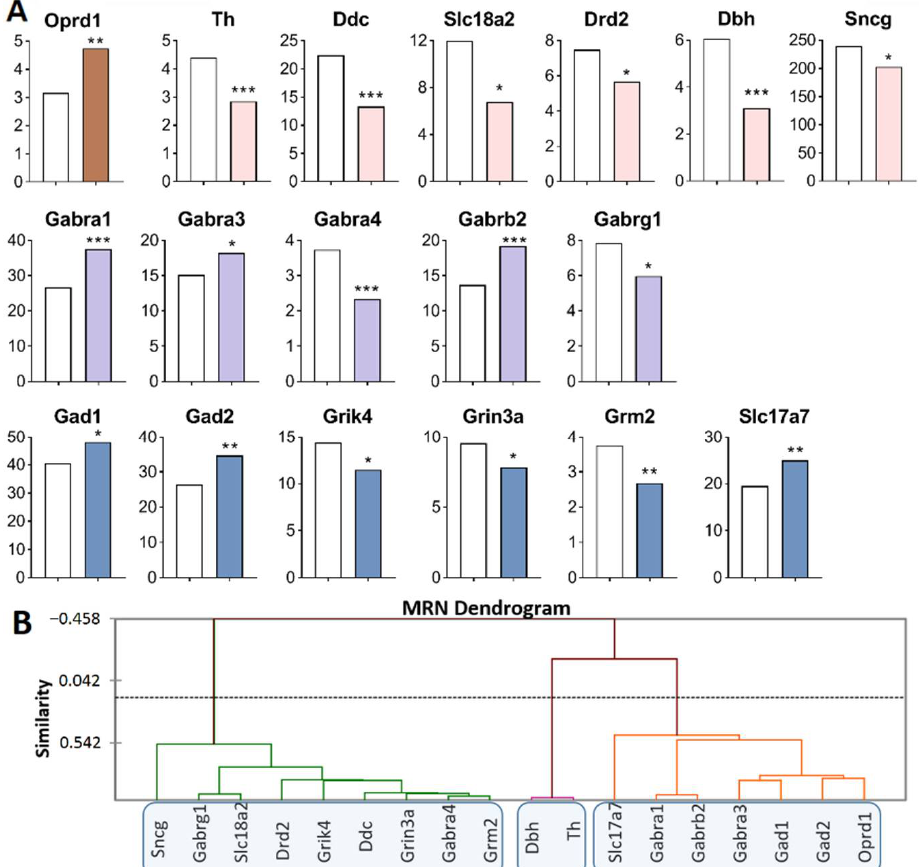
Figure 5. DEGs in the MRNs of highly aggressive mice. ( A ) FPKM of opioidergic, CAergic, GABAer- gic and glutamatergic DEGs in the MRNs (Supplementary Table S1). White bars—controls; colored bars—winners: brown—opioidergic genes; pink—CAergic genes; lilac—GABAergic genes; violet— glutamatergic genes. * p < 0.05; ** p < 0.01; *** p < 0.001. ( B ) AHC based on expression profiles of 18 reference DEGs (Supplementary Table S2). Similarity: Pearson’s correlation coefficient. Agglom- eration method: Unweighted pair-group average. The main clusters are highlighted with a blue rounded rectangle.